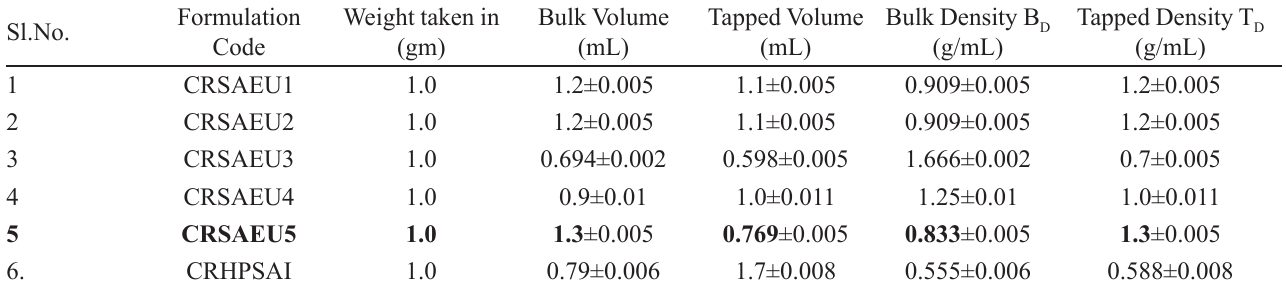
TABLE IV - Bulk and tapped density of formulations (Mean ±S.D) Sl.No.